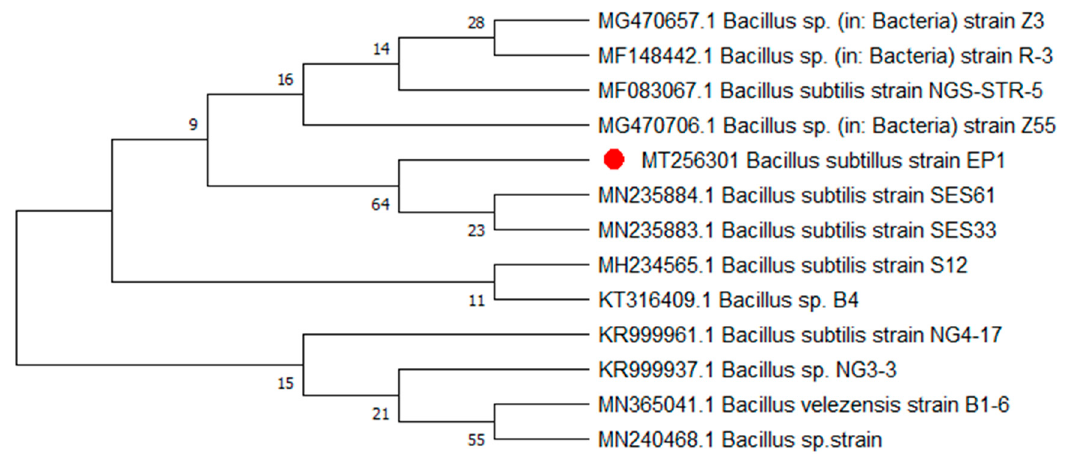
Figure 1. Phylogenetic tree of the isolated strain B. subtilis strains EP1. The strain is highlighted by the red bullet. The tree was constructed using maximum likelihood with bootstrap values (1000).